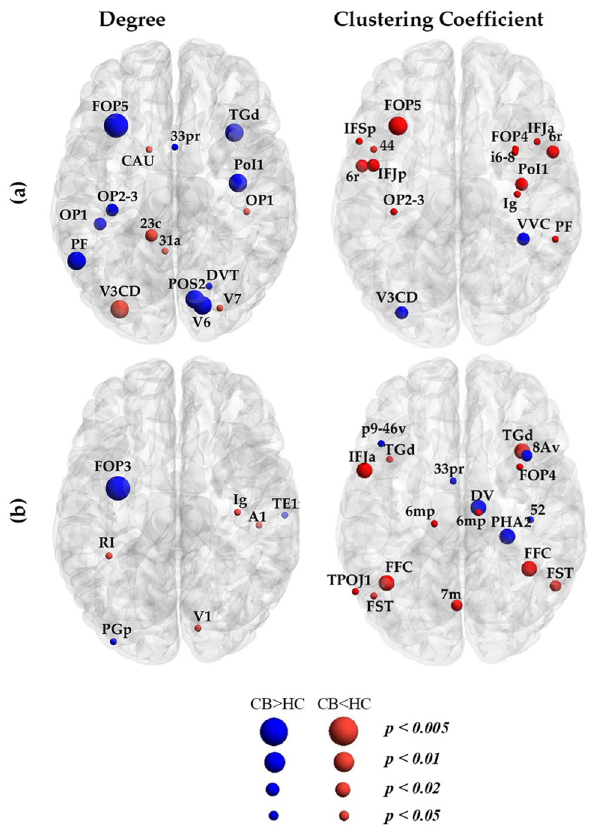
Figure 2. Regions showing differences in degree and clustering coefficient between cannabis users and healthy controls in ( a ) structural networks and ( b ) functional networks. The color of nodes indicates significant increases (red) or decreases (blue) in degree and clustering coefficient for cannabis users (CB) compared to healthy controls (HC). The size of nodes represents between group differences with p < 0.05, p < 0.02 , p < 0.01 and p < 0.005 ( uncorrected ) with larger nodes showing smaller p values.